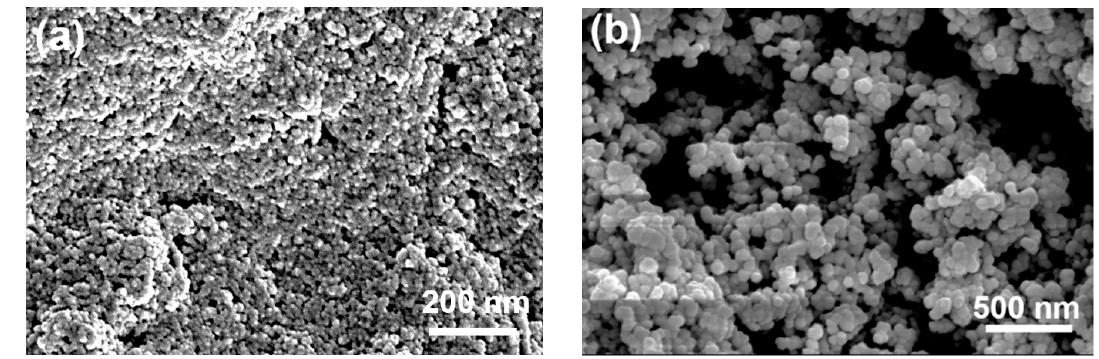
Figure 1. Field emission scanning electron microscopy image of as-received ZrO 2 NPs of varying size: ( a ) ZrO 2 A (5–15 nm) and ( b ) ZrO 2 B (70–90 nm) nanoparticles.